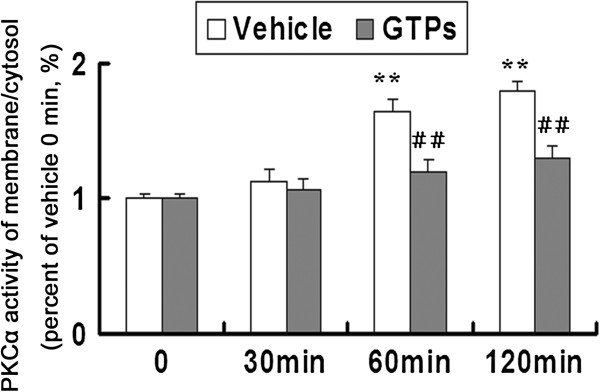
Effects of GTPs on plasma membrane translocation of PKCα at the early stage of brain ischemia were determined by specific PKCα assay. Quantification of PKC activity in the membrane-to-cytosol ratio was expressed as a fold increase relative to the vehicle group of ischemia at 0 min. Data represent the means ± SD (n = 6, each). **P < 0.01 vs. vehicle group of ischemia 0 min. ##P < 0.01 vs. vehicle group at the same time points.